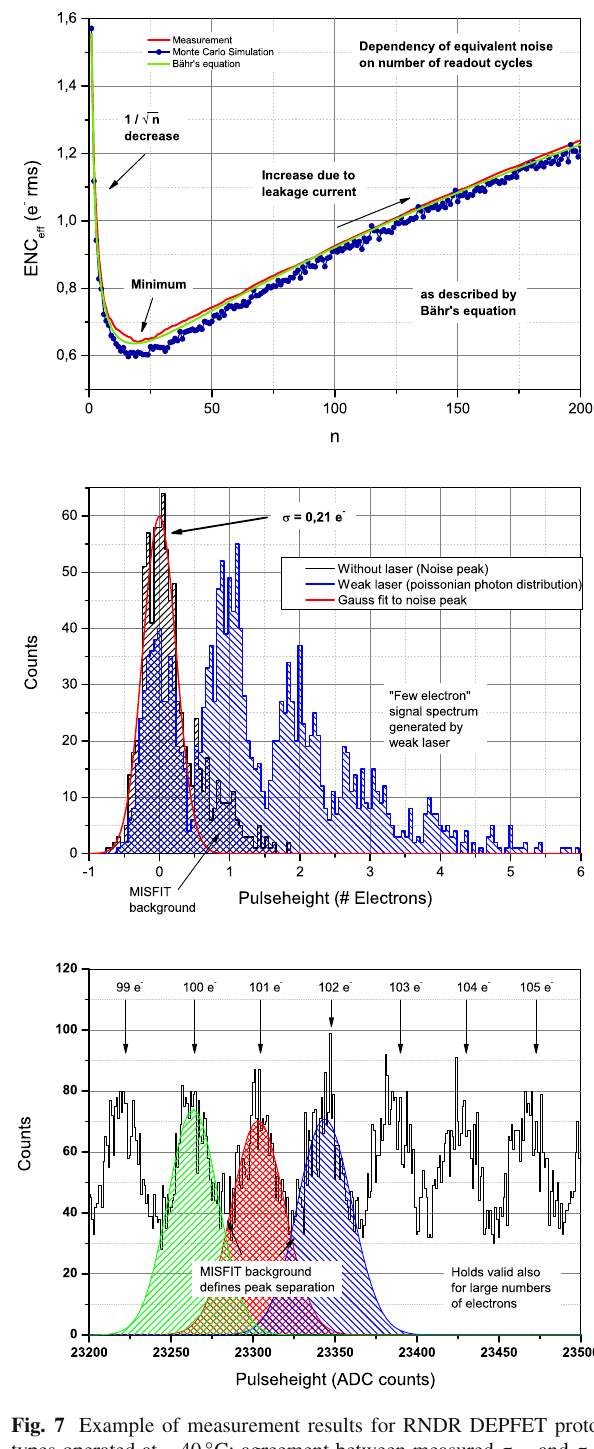
Fig. 7 Example of measurement results for RNDR DEPFET proto- types operated at − 40 ◦ C: agreement between measured σ eff and σ eff predicted both by Monte Carlo and Bähr’s equation (top), single elec- tron spectra taken for weak (middle) illumination intensities exhibiting the expected poisson distribution, and peak separation for higher illu- mination intensities (bottom). From the distance of the single electron peaks, a σ opt of 0 . 2 e − ENC can be eff